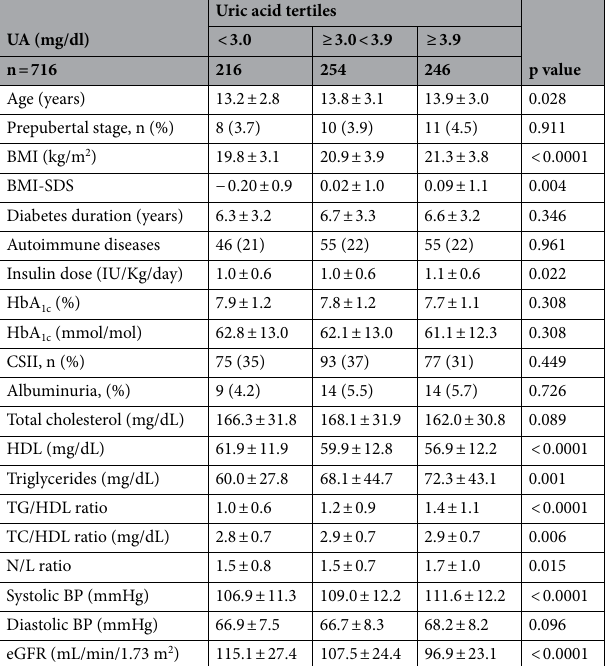
Table 2. Anthropometric and biochemical features in boys according to tertiles of uric acid. Data are expressed as mean ± SD, n (%). p values are for trends across tertiles. HbA 1c : glycosylated hemoglobin, CSII: continuous subcutaneous insulin infusion. MDI: multiple doses of insulin. IU/Kg/day: insulin dose pro Kg Day. TG/HDL ratio: triglycerides to HDL ratio. TC/HDL ratio: Cholesterol to HDL ratio. SPISE: single-point insulin sensitivity estimator N/L ratio: Neutrophil/Lymphocyte ratio. BP: blood pressure. eGFR: estimated glomerular filtration